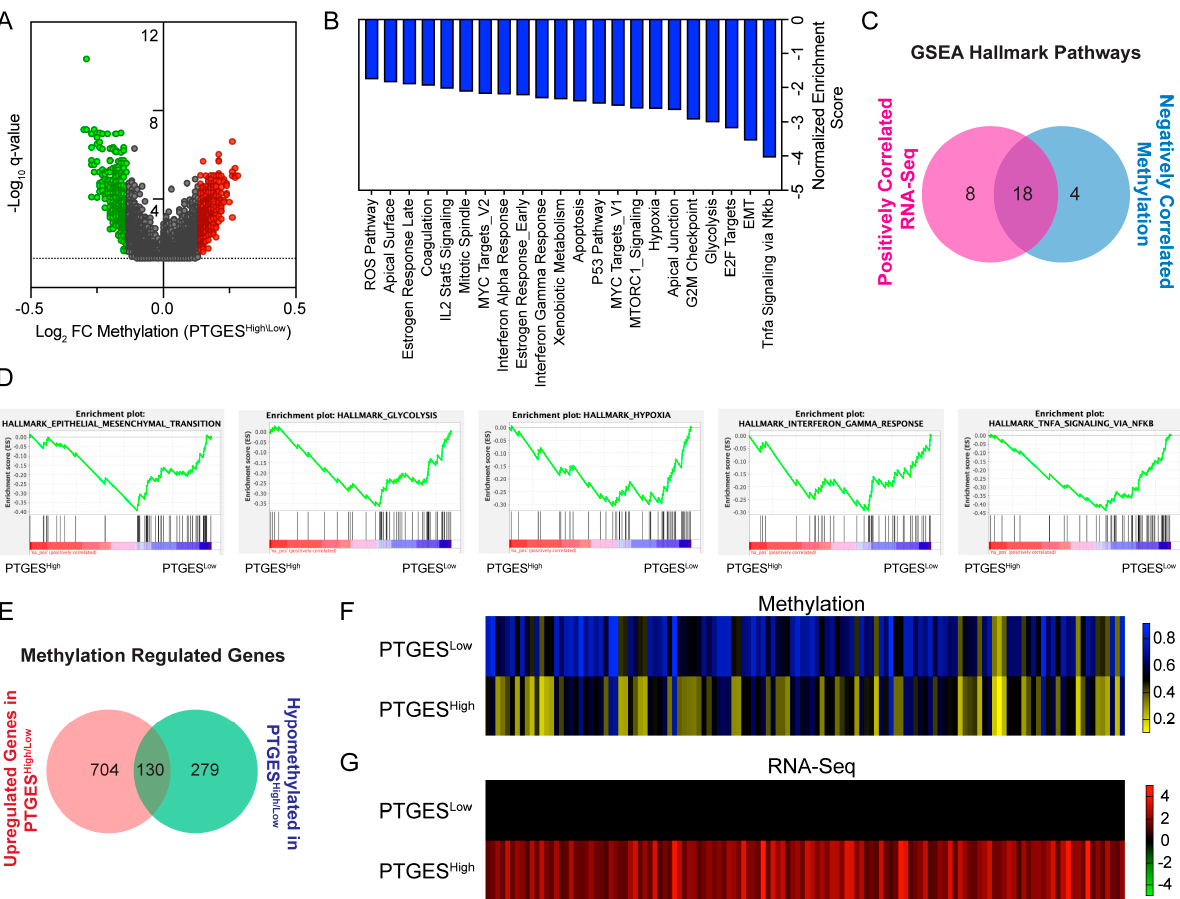
Figure 5. Correlation of DNA methylation with mRNA expression in PDAC patients based on PTGES expression. ( A ) Volcano plot and ( B ) barplot showing GSEA pathway enrichment analysis of significantly hypo- and hypermethylated genes between the PTGES High and PTGES Low groups in pancreatic cancer patients. ( C ) Venn diagram of GSEA hallmark pathways between positively enriched pathways in RNA-Seq data and negatively enriched pathways in methylation data correlated with high PTGES expression. ( D ) GSEA plots of selected common regulated pathways. The plots shown are negatively enriched pathways with PTGES expression from methylation data. ( E ) Venn diagram shows the genes regulated by methylation. The upregulated genes in RNA-Seq data are compared with hypomethylated genes from the methylation analysis. ( F ) Heatmap showing methylation status of the commonly identified 130 genes between the PTGES High and PTGES Low patient groups. The color key shows the percentage methylation change. ( G ) Heatmap showing expression changes of the commonly identified 130 genes between the PTGES High and PTGES Low patient groups. The color key shows log2 fold changes in expression.